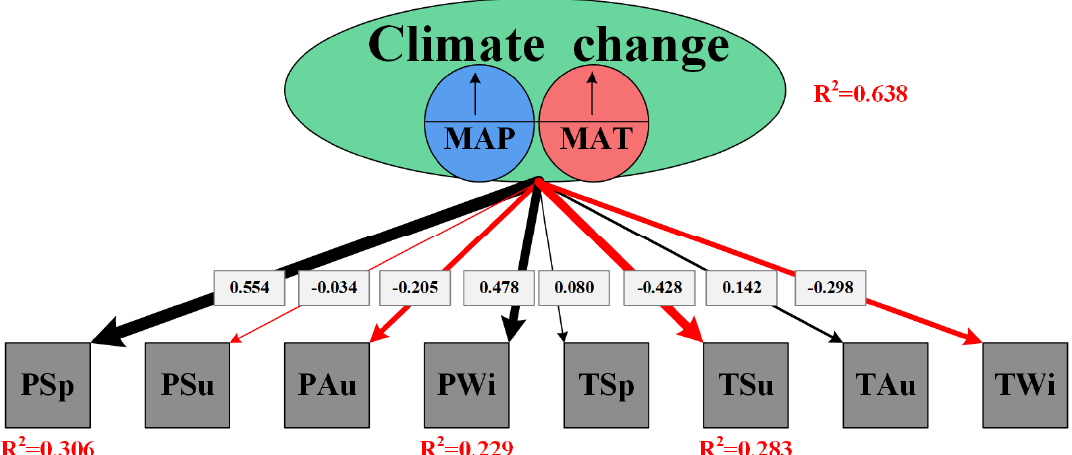
Figure 6. SEM was used to analyze the direct and indirect effects among variables in the Tibetan Plateau. The standardized total coefficients are listed on each path. The thickness of the solid arrows reflects the magnitude of the standardized SEM coefficients, the black solid line represents the positive effect, and the red solid line represents the negative effect. MAP and MAT represent the mean annual precipitation and mean annual temperature, respectively; PSp, PSu, PAu, and PWi represent vegetation sensitivity to precipitation in spring, summer, autumn, and winter, respectively; and TSp, TSu, TAu, and TWi represent vegetation sensitivity to temperature in spring, summer, autumn, and winter, respectively. Table 2. Summary of the direct, indirect, and total effects of the variables (GW, MAP, MAT, PSp, PSu, PAu, PWi, TSp, TSu, TAu, and TWi) in the SEM of the Tibetan Plateau. The effects were cal- culated with standardized path coefficients.